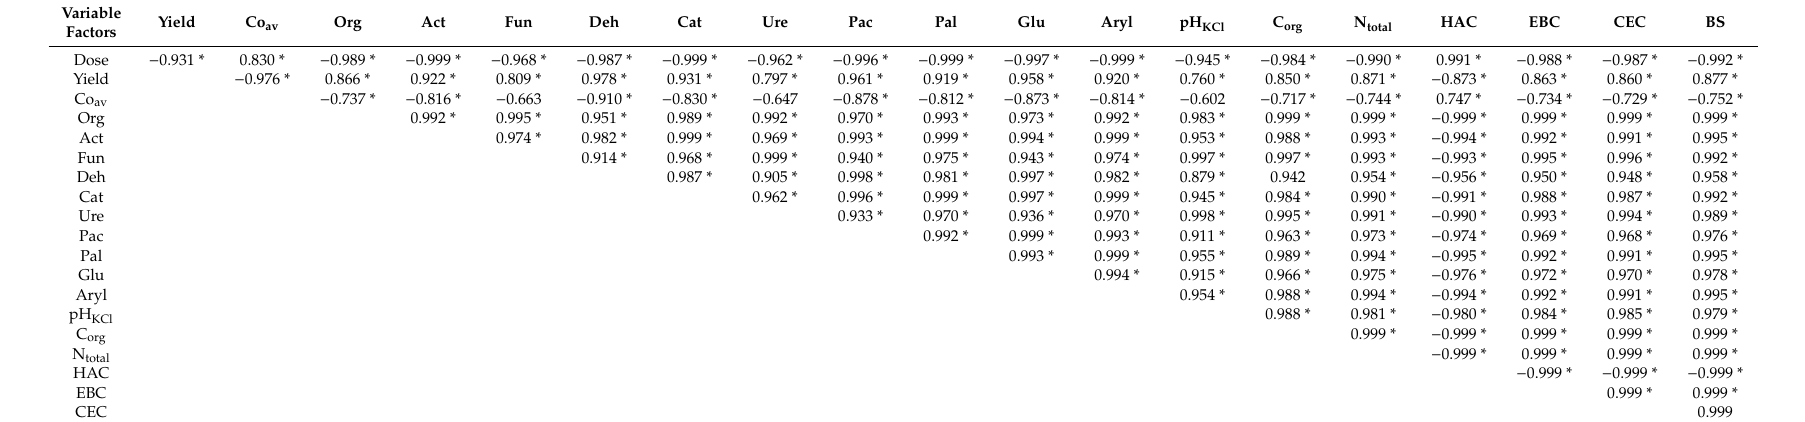
Table 19. Coe ffi cients of correlation between variables in treatments sown with sandy clay